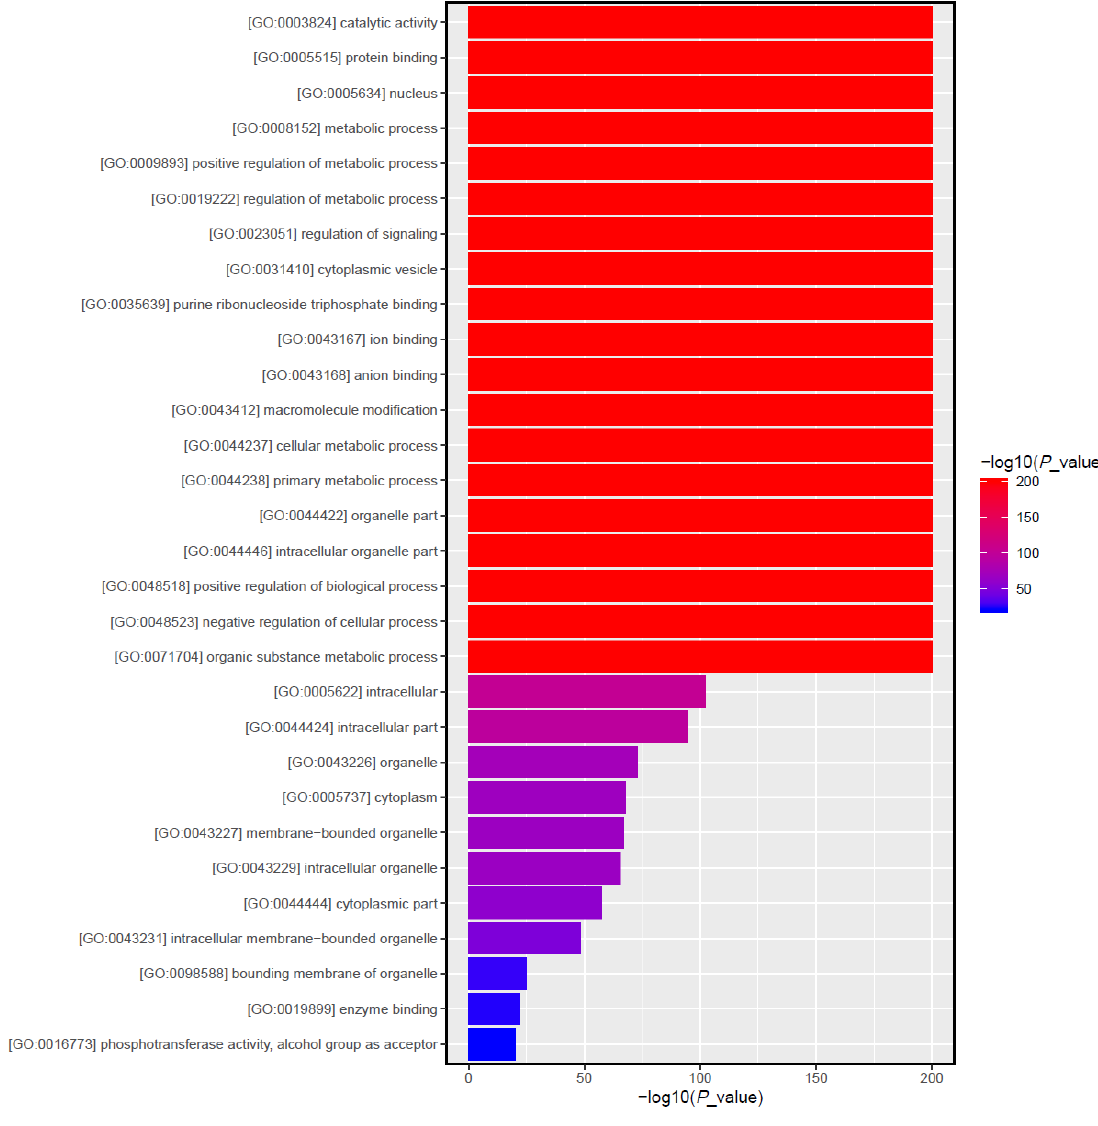
Figure 6. Functions associated with differentially expressed miRNA target genes identified by GO enrichment analysis. Bar graph of GO enrichment of differential genes intuitively reflects the distribution of the number of differential genes on GO term enriched in BP, CC, and MF. The 30 GO terms with the most significant enrichment were picked. Each column in the figure is a GO term, and the abscissa text indicates the name of the GO. The length of the column and the abscissa indicate the significance of the enrichment, which is the p -value; a darker color indicates a more significant enrichment of the function, and the color gradient on the right indicates the p -value size.